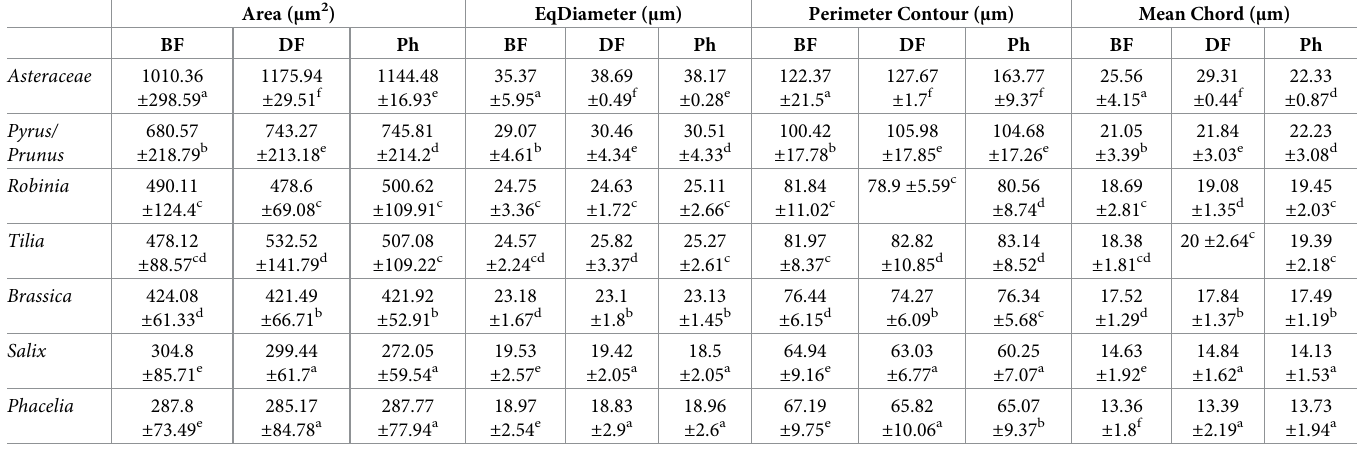
Table 4. Size depended morphological